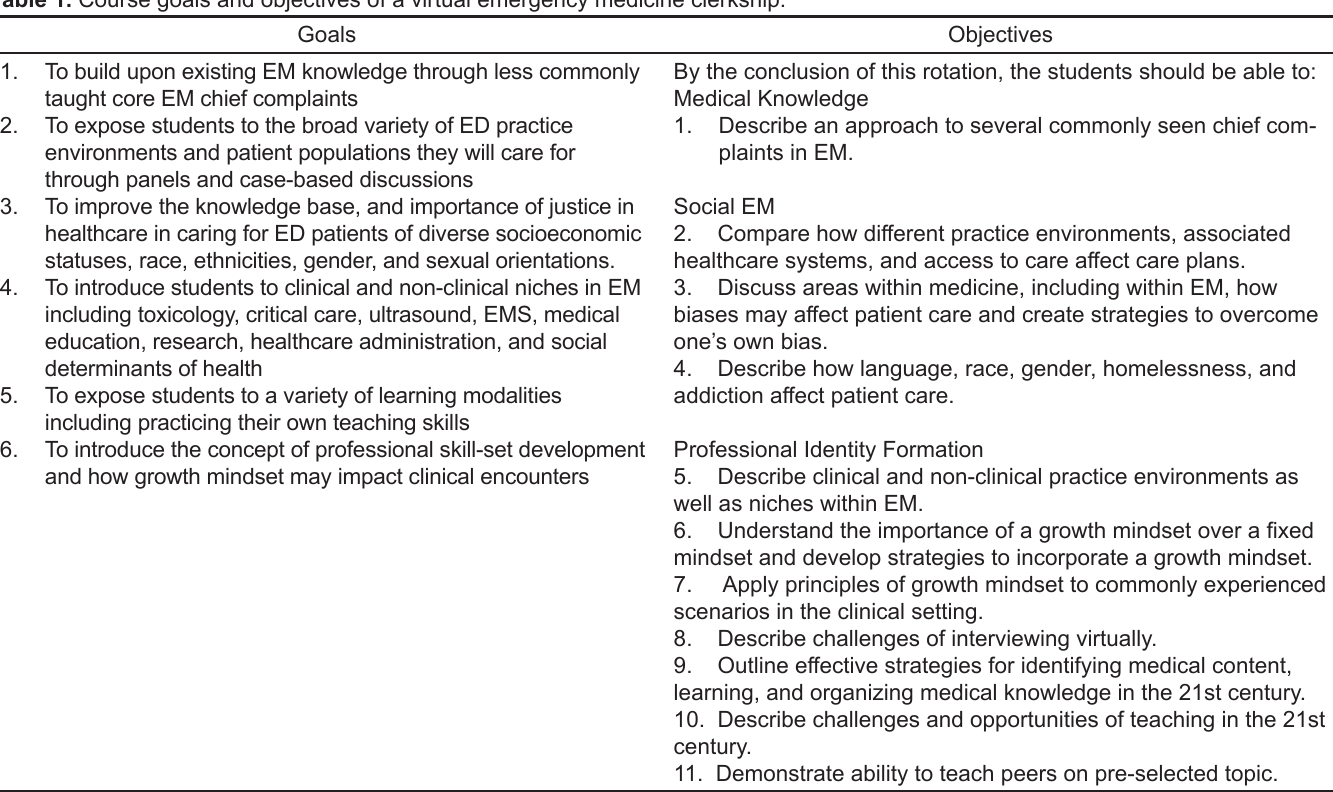
Table 1. Course goals and objectives of a virtual emergency medicine